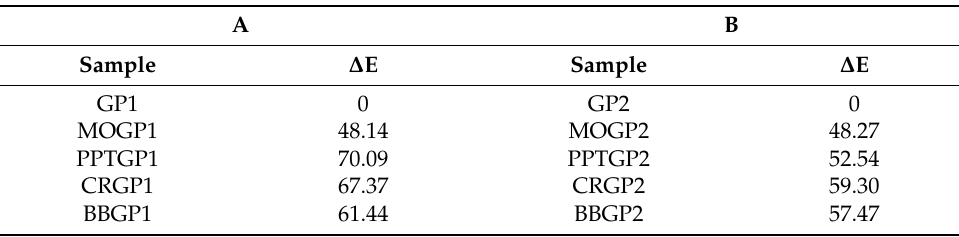
( B ) ∆ E of the samples (24 h at 40 °C) compared to white sample GP2.